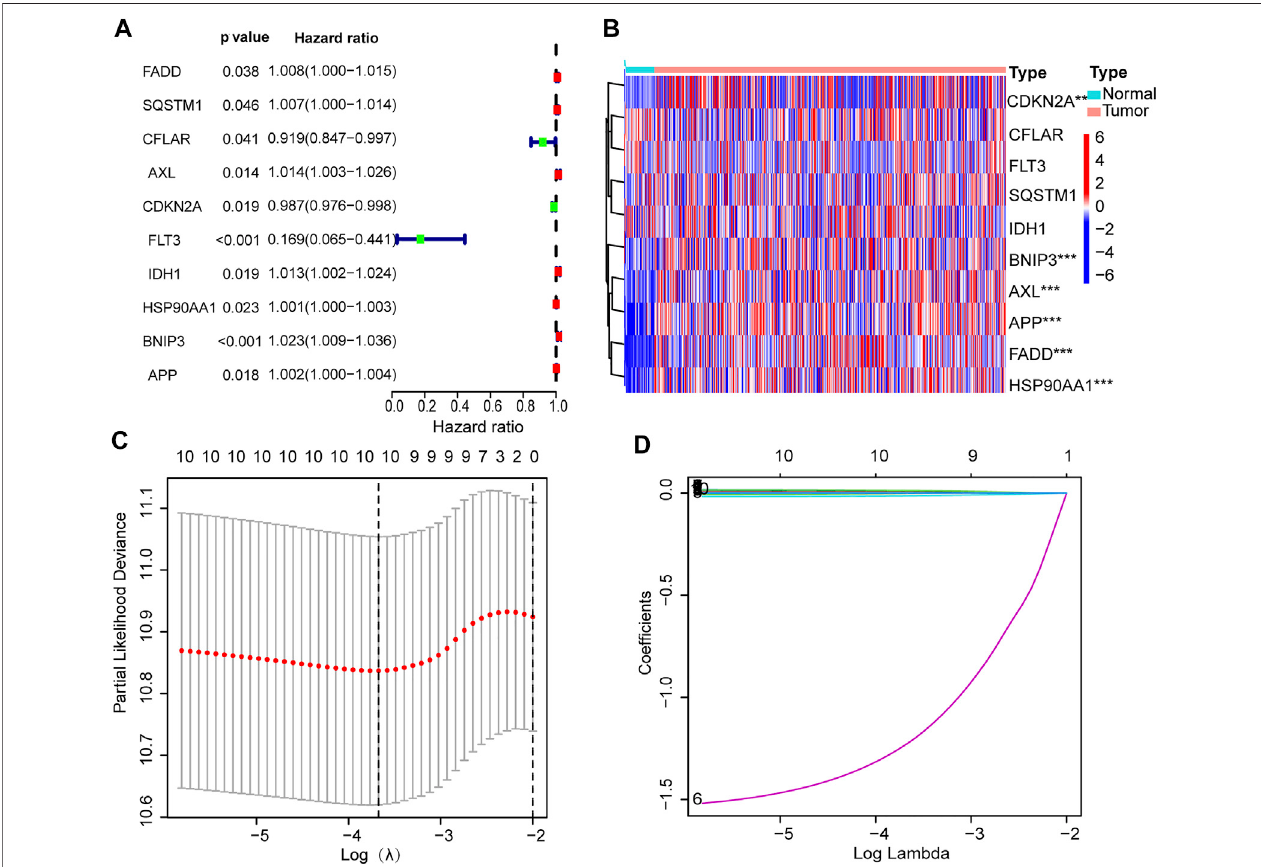
FIGURE 4 | Establishment of prognostic signature. (A) Ten prognostic genes with p values. (B) Heat map of gene expression. (C) LASSO analysis with 10-fold cross-validation identi fi ed 6 prognostic genes. (D) Coef fi cient pro fi le plots of 6 prognostic genes.